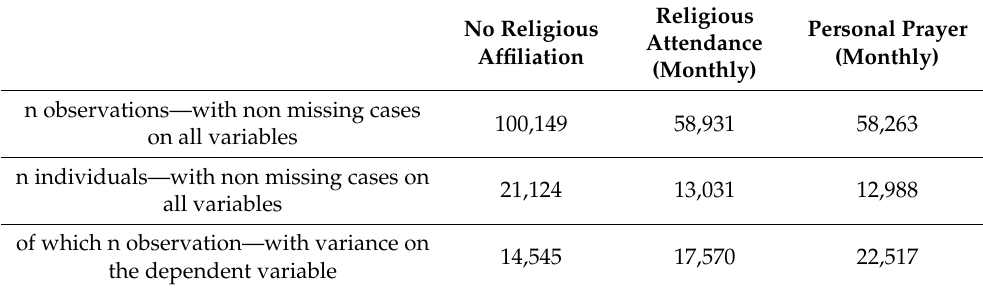
Table 1. Distribution and descriptive statistics of used data (column % summing to 100% in